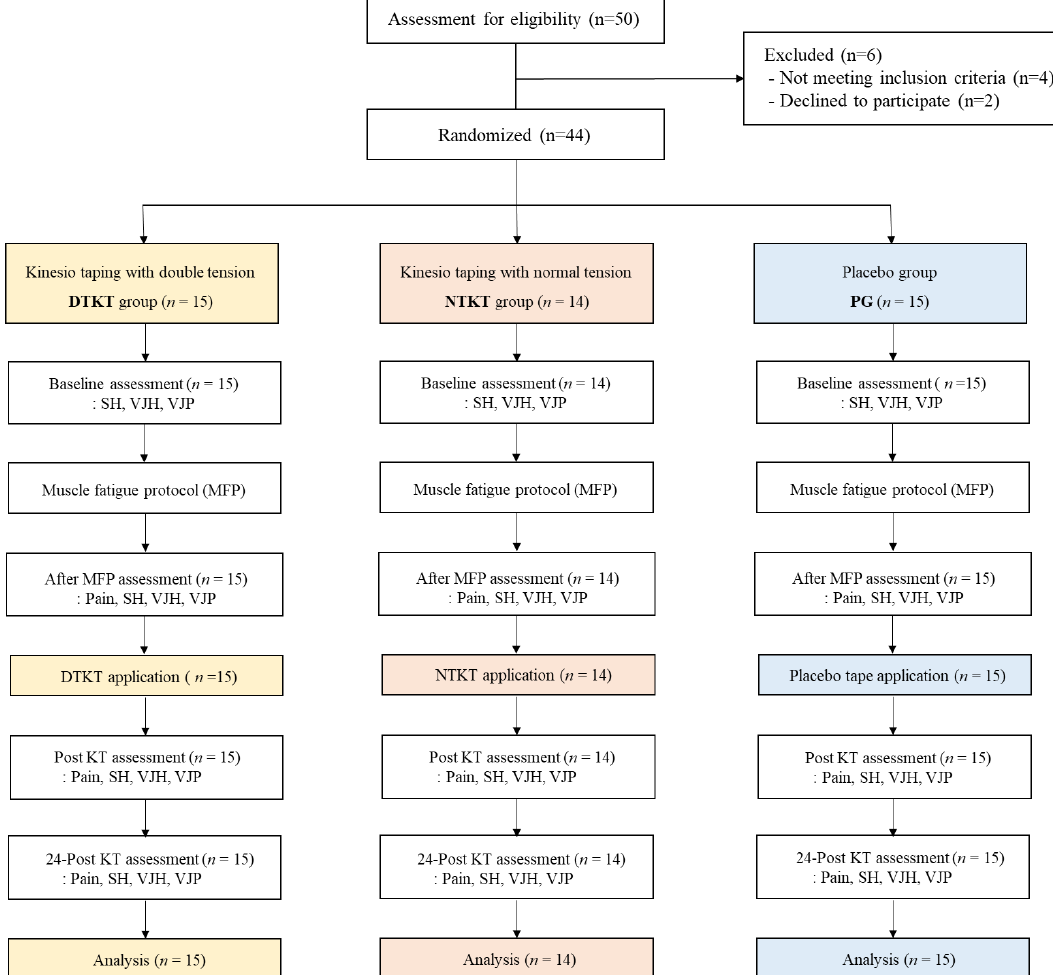
Figure 1. Flowchart diagram of the study. Abbreviations: SH, single hopping; VJH, vertical jump height; VJP, vertical jump power